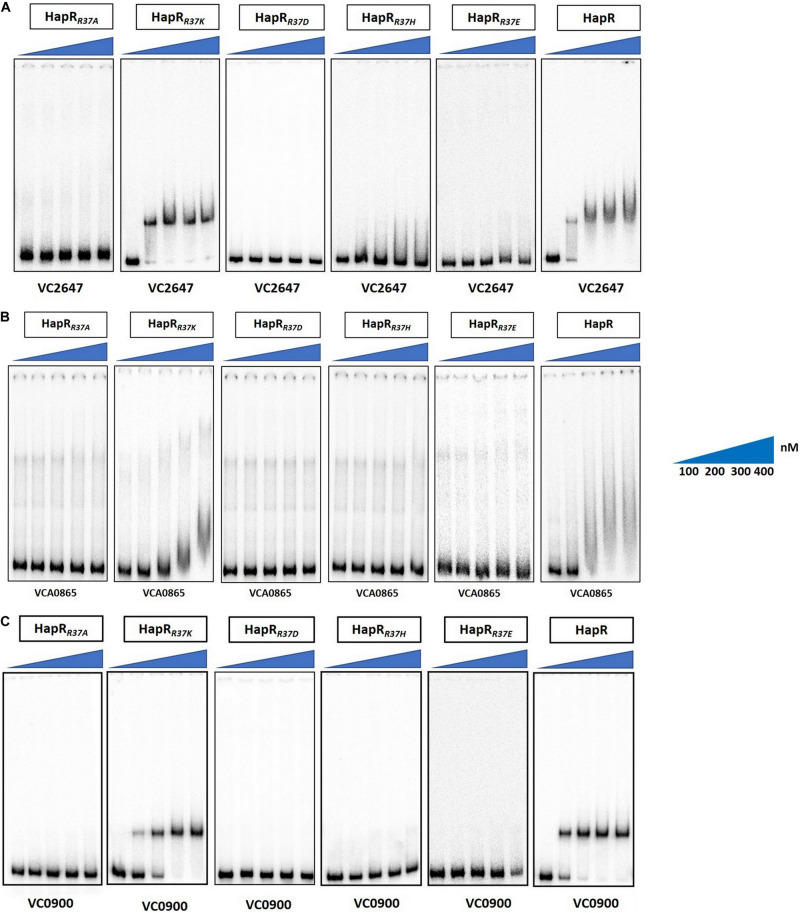
Gel shift experiments of HapR and its R37 mutants. Electrophoretic mobility shift assay (EMSA) of the purified wild-type protein HapR and its mutants HapRR37A, HapRR37K, HapRR37D, HapRR37H, and HapRR37E was performed with 32P-labeled promoter regions of (A)
aphA (VC2647), (B)
hapA (VCA0865), and (C)
cdgG (VC0900). The solid wedges represent the increasing concentrations of proteins. The results are representative of two or more experiments.